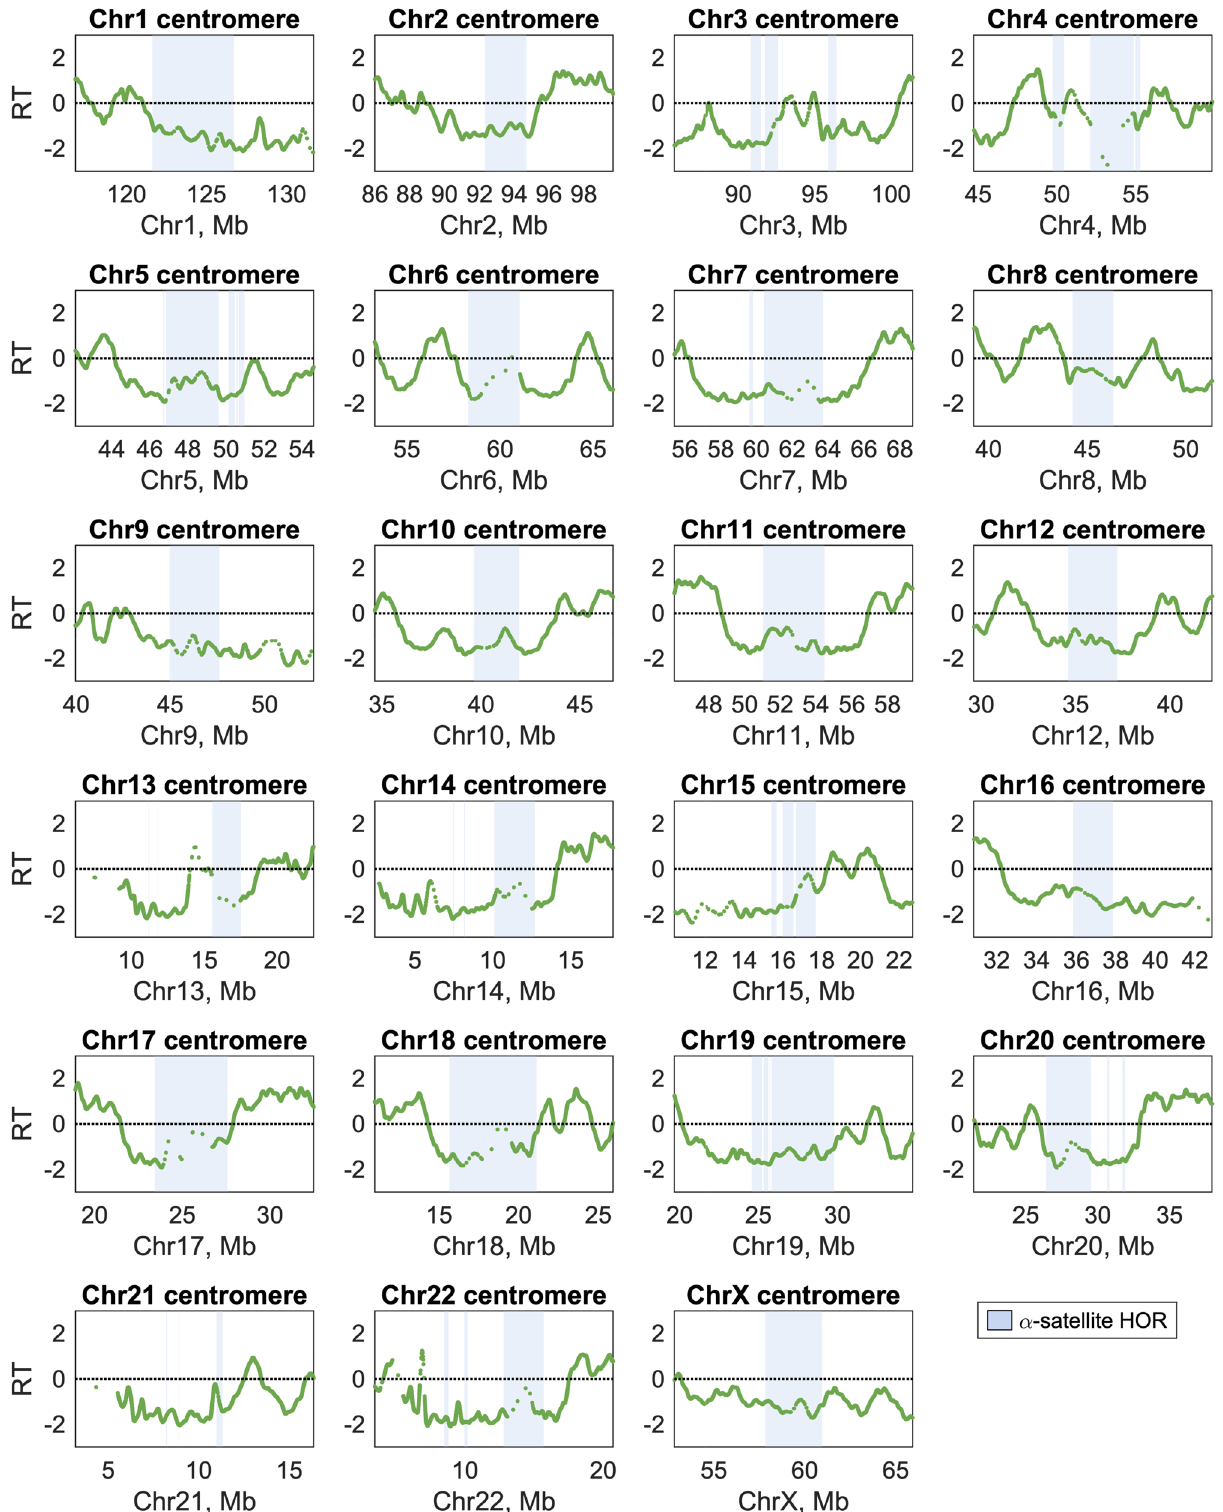
Figure 3. Centromeric replication timing (RT) of all human autosomes and chromosome X. The locations of α-satellite higher-order repeats on each chromosome, which scaffold active centromere assembly, are indicated in blue. For each chromosome, the entire region shown is annotated as centromeric. The RT profile for the lymphoblastoid cell line GM12878 is shown for each